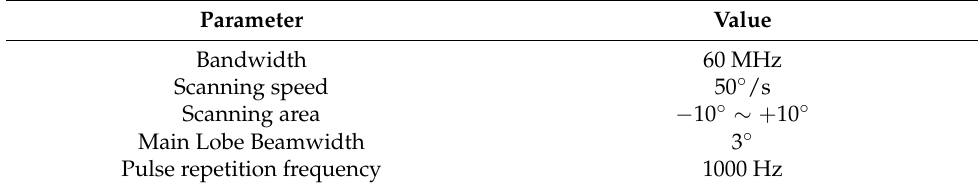
Table 2. Area simulation parameters.